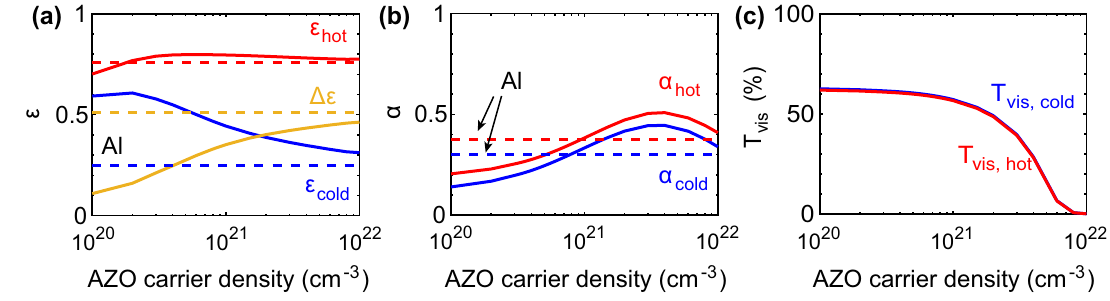
Figure6: EffectofAZOcarrierdensityontheVO 2